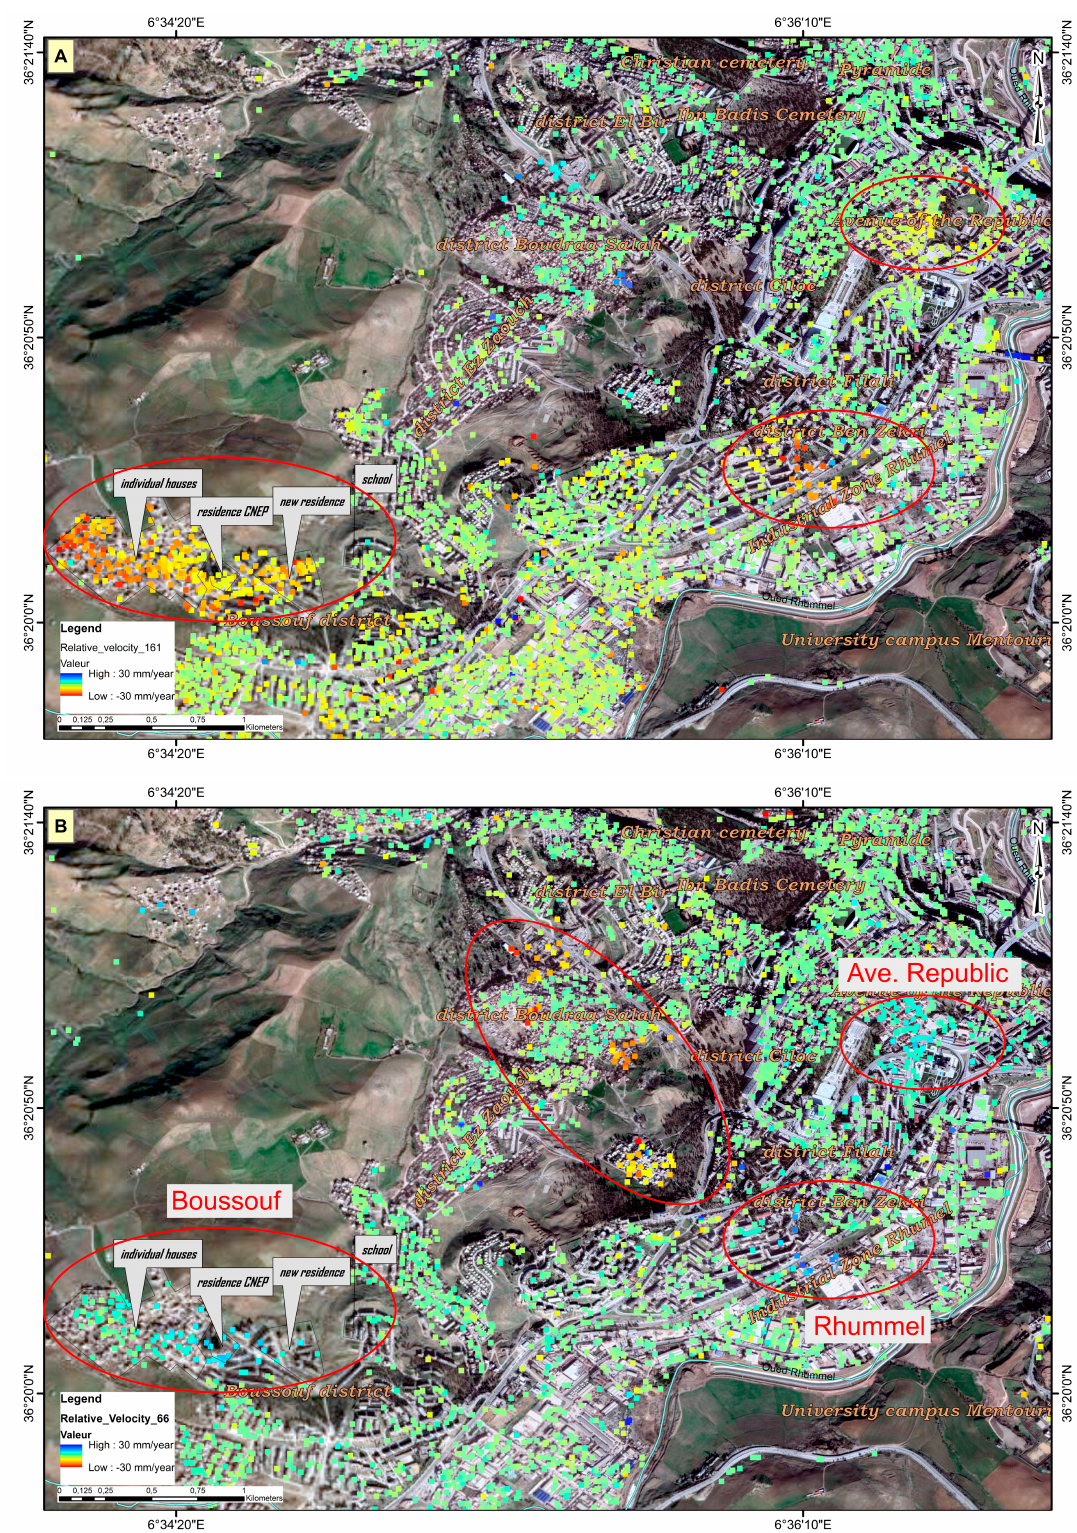
Figure 9. LOS mean deformation velocity map of Constantine (center) of tracks 161 ( A ) and 66 ( B ). The negative motion, i.e., motion away from the sensor, shown in the data from the descending orbit and the positive motion, i.e., motion toward the sensor, shown in the ascending orbit, indicates horizontal motion roughly toward west.